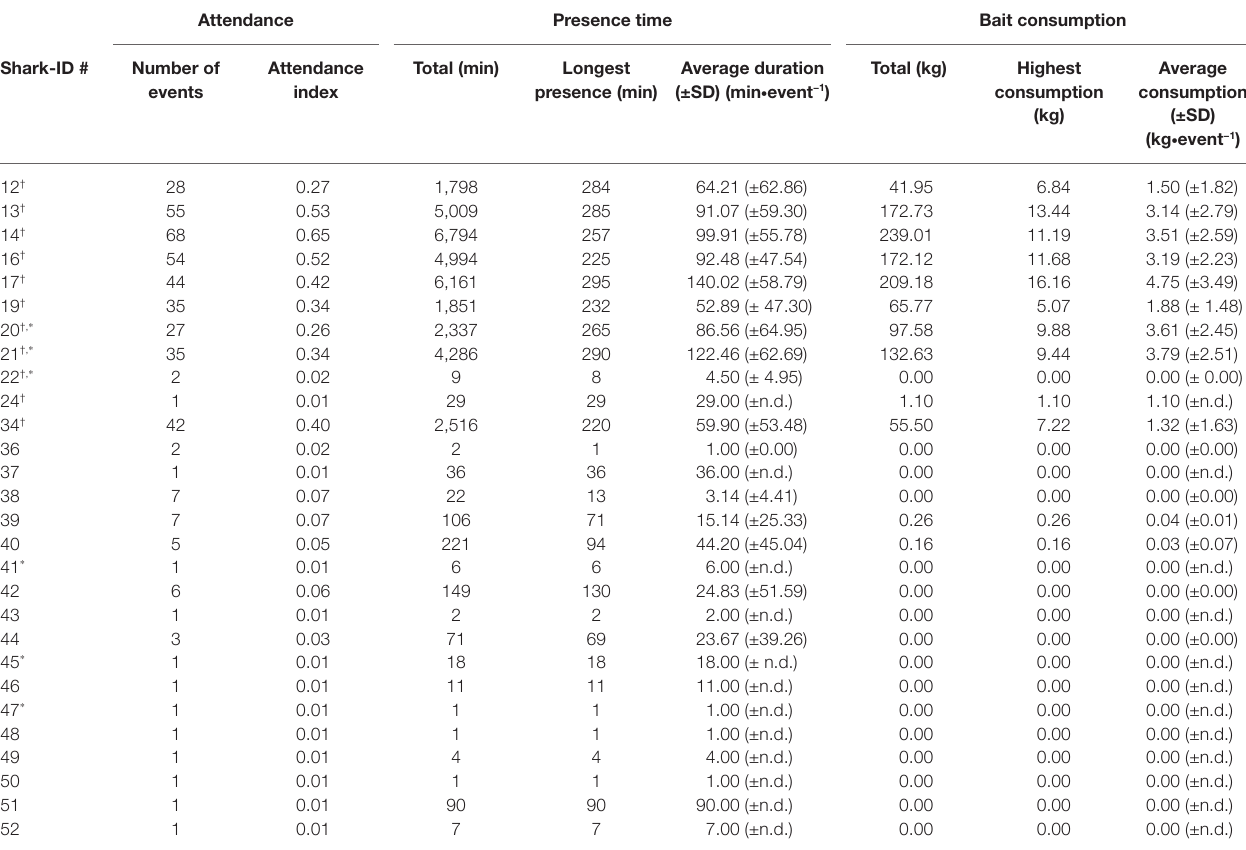
TABLE 2 | Overview table with provisioning site measures for all identified great hammerhead sharks ( S. mokarran